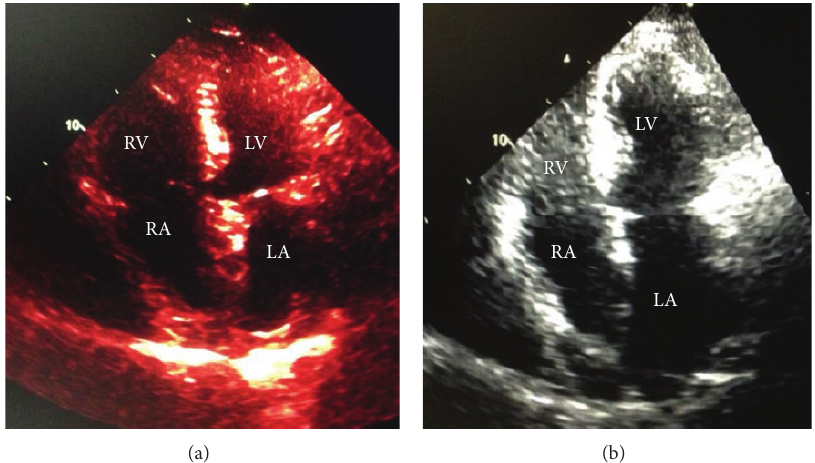
Figure 5: Two-dimensional transthoracic echocardiography in the apical four-chamber view. Panel (a) was obtained prior to surgical correction and demonstrates significant right atrial and ventricular enlargement. Panel (b) was obtained six months following surgical correction and demonstrates normalization of the right atrial and ventricular sizes. RA: right atrium; RV: right ventricle; LA: left atrium; LV: left